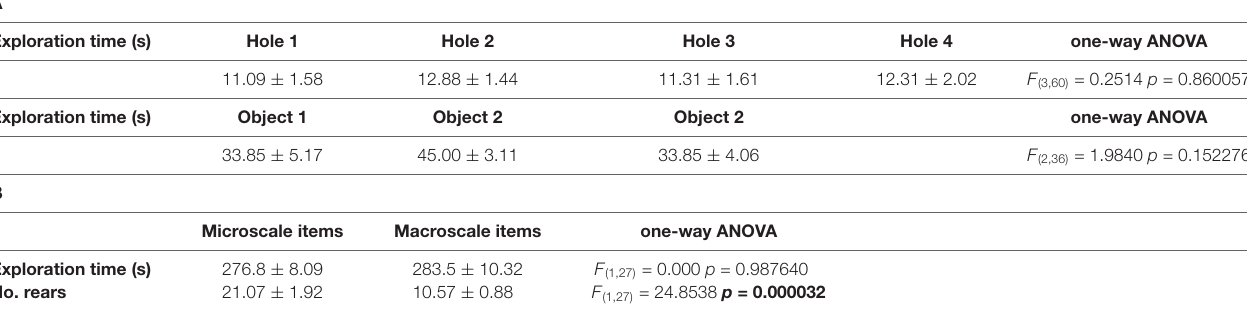
TABLE 2 | Animal behavior in the microscale and macroscale cue paradigms.